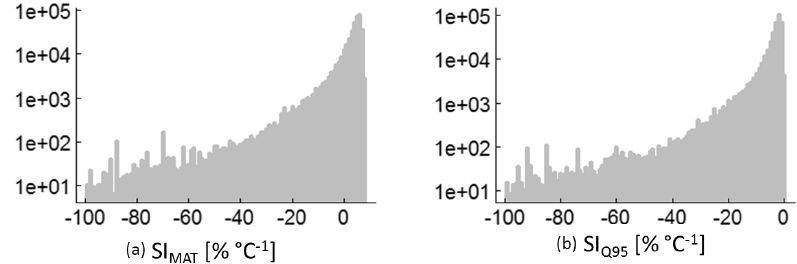
Figure B1. Frequency distribution of SI MAT values (a) and SI Q 95 values (b) of all forest